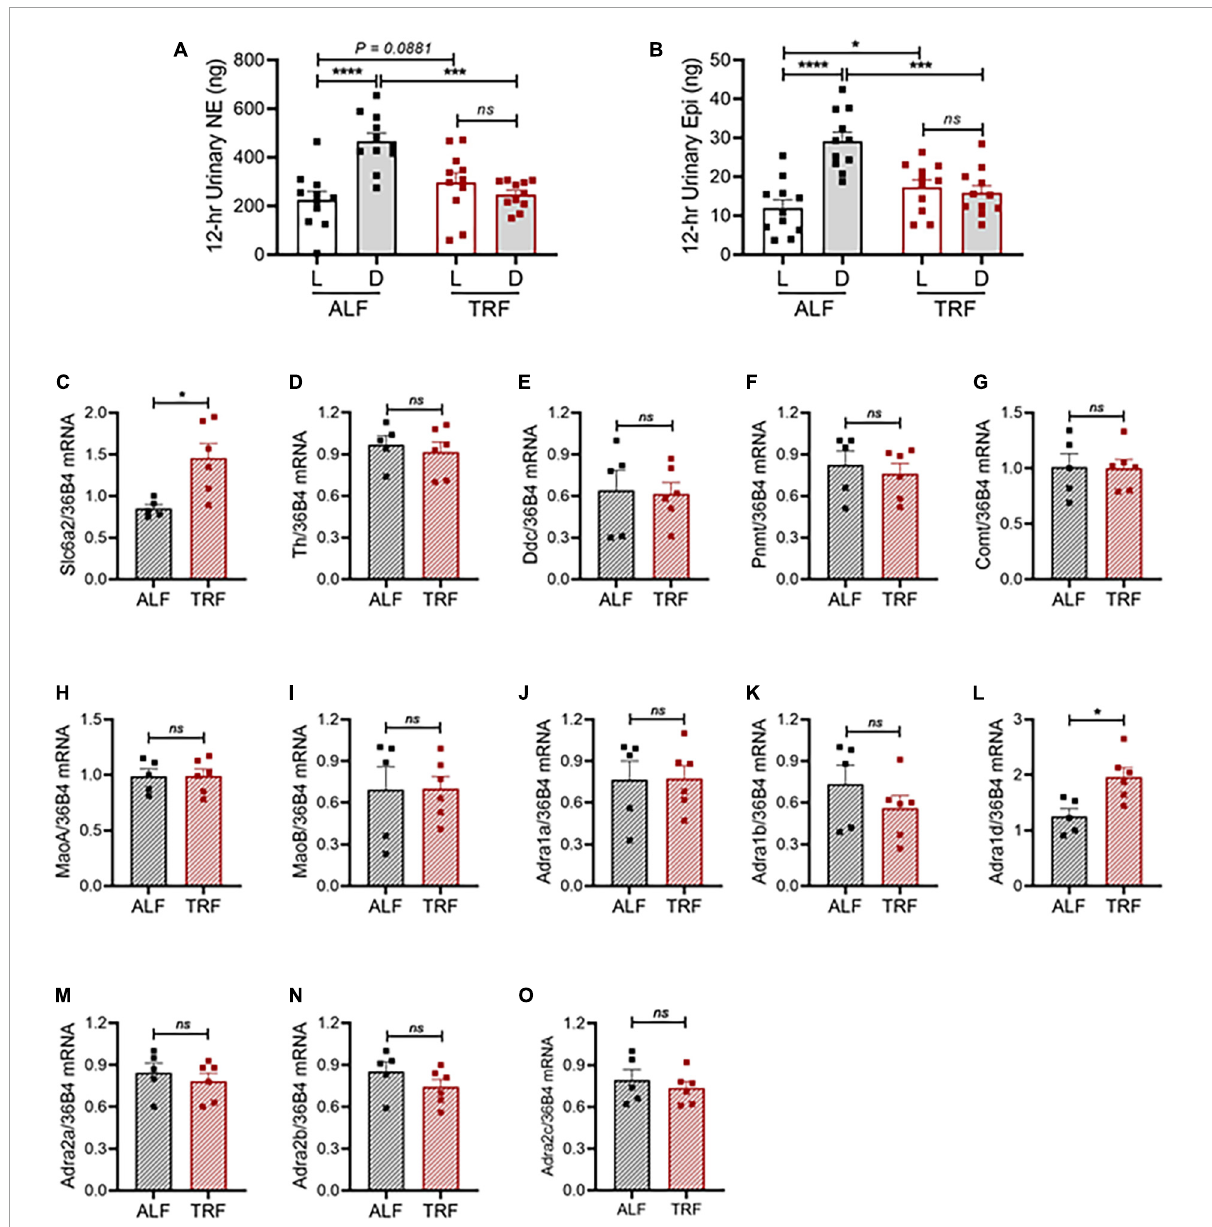
FIGURE5 Light-phase TRF alters the sympathetic pathway. (A,B) Urinary norepinephrine [NE; (A) ] and epinephrine [Epi; (B) ] during the light and dark phases in 15- to 16-week-old male mPer2 Luc mice ( N = 11) under ALF and the 7th day of light-phase TRF. (C–O) mRNA expression of solute carrier family 6 member 2 [( Slc6a2 , (C) ], tyrosine hydroxylase [ Th , (D) ], dopa decarboxylase [ Ddc , (E) ], phenylethanolamine N -methyltransferase [ Pnmt , (F) ], catechol-O-methyltransferase [ Comt , (G)] , monoamine oxidase A [ MaoA , (H) ], monoamine oxidase B [ MaoB , (I) ], alpha-1a adrenergic receptor [ Adra1a , (J) ], alpha-1b adrenergic receptor [ Adra1b , (K) ], alpha-1d adrenergic receptor [ Adra1d , (L) ], alpha-2a adrenergic receptor [ Adra2a , (M) ], alpha-2b adrenergic receptor [ Adra2b , (N) ], and alpha-2c adrenergic receptor [ Adra2c , (O) ] in mesenteric arteries isolated during ZT9 to ZT11 from 20-week-old male mPer2 Luc mice under ALF and 7 days after light-phase TRF. N = 5 or 6 in each group. Data were expressed as the mean ± SEM and analyzed by repeated two-way ANOVA with matching conditions between light vs. dark phase and between ALF vs. light-phase TRF with Tucky’s post hoc analysis (A,B) or unpaired t-test (C–O) . * P < 0.05; *** P < 0.001; **** P < 0.0001; ns, not